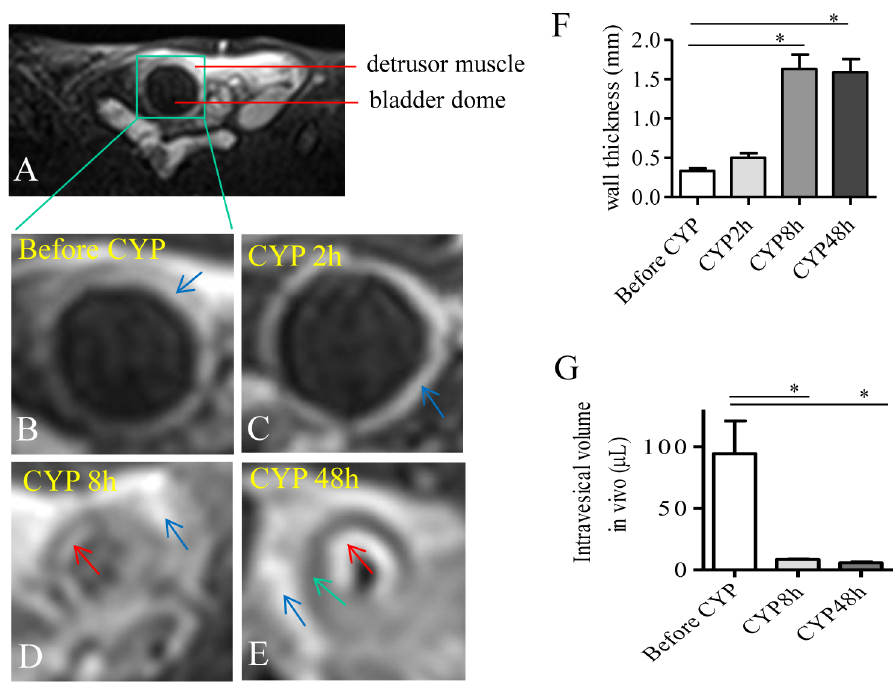
Fig. 1. MRI visualization demonstrated an increase in the thickness of bladder wall and a decrease in the volume of bladder dome during CYP-induced cystitis. A spin-echo T2-weighted MR sequence was performed to visualize the urinary bladder in the pelvis on axial sections (A). The same animal was scanned before (B) and after CYP treatment (C-E). At 2 h after cystitis was induced, the anatomy of the urinary bladder appeared similar to control. At 8 h and 48 h post cystitis induction, the thickness of the bladder wall was significantly increased (F) which was accompanied with a decrease in intravesical volume (G). Summary results were from 5 animals before and after CYP injection. *, p ,